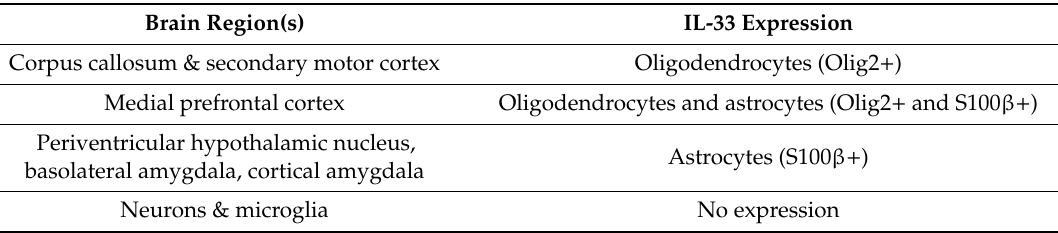
Table 3. IL-33 expression in various brain